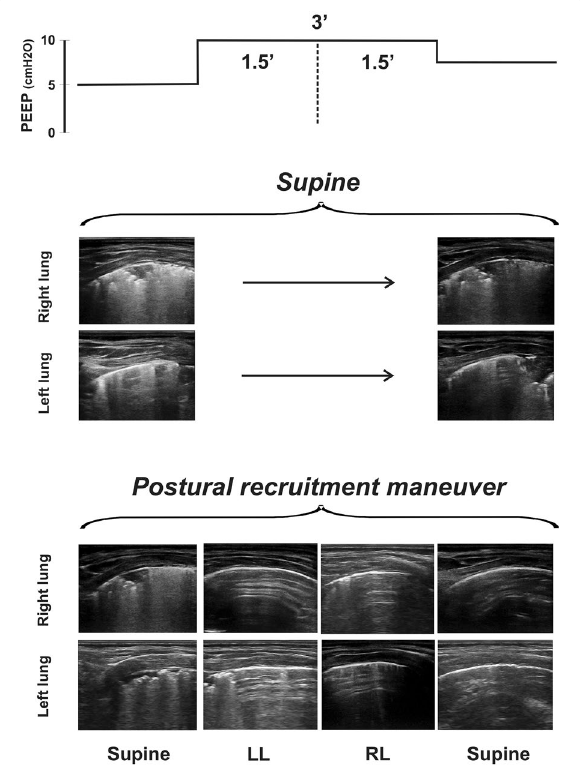
Additional file 3: video S3 show the corresponding